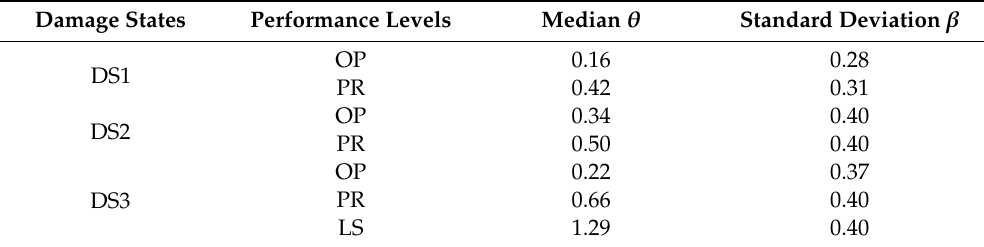
Table 7. Values of limit states of the mold